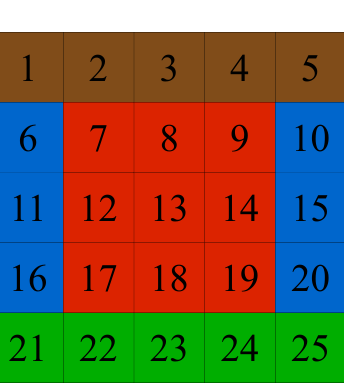
Fig. 4. Structure of system 3. Red: area with strong P - V -feedback (hotspot), blue: passively dependent on red area, brown: dry area, green: moist area.